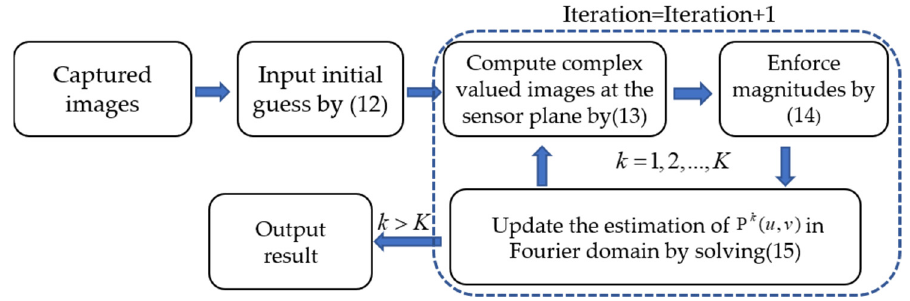
Figure 3. The algorithm flow chart of the local aberration recovery process.